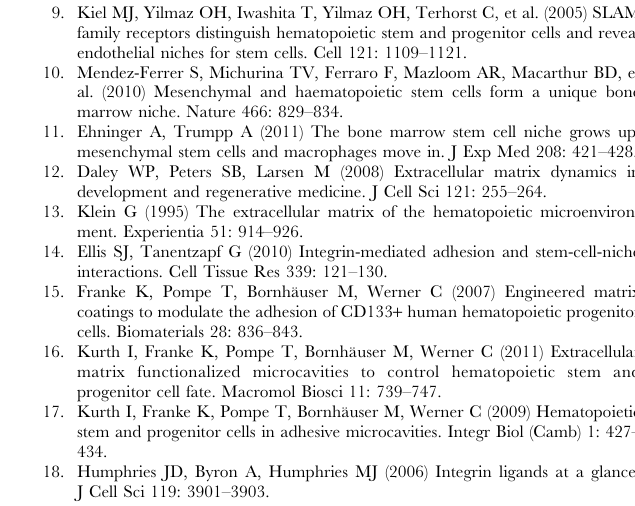
expressed as percentage in relation to the proliferation on unfunctionalized gold control surfaces. (B) The percentage of CD34 positive cells was determined after HSPC incubation for 4 or 7 days on glass slides biofunctionalized with different ligands. (C) Representative histograms of flow cytometry analyses of CFSE labeled cells after 4 days incubation on biofunctionalized glass surfaces. The respective ligands are named in the top left corner of each histogram and the number of cell divisions is indicated by vertical, dashed lines. (D) CD34 expression of HSPCs after 4 (red curve) and 7 (blue curve) days of incubation on biofunctionalized glass surfaces; The CD34 isotype control is shown in gray. N independent experiments = 4; error bars = standard deviation of the mean; gold = homogeneous gold film on glass; FN D RGD is abbreviated with ‘‘ D RGD’’. (TIF) Figure S8 Immunofluorescence THBS2 staining of HSPCs. Representative microscopic images of HSPCs incubated for 13 h on nanostructured, biofunctionalized hydrogels. The top row of images shows bright field images, in the middle row THBS2 is made visible by Alexa Fluor 488 fluorescence staining (green), and in the bottom row cell nuclei are made visible by Dapi staining (blue). The negative control was incubated without the primary antibody. One representative experiment (based on one donor) of 3 is shown. 20 cells per donor were analyzed on each substrate and one cell per substrate is shown. Scale bar= 10 m m.